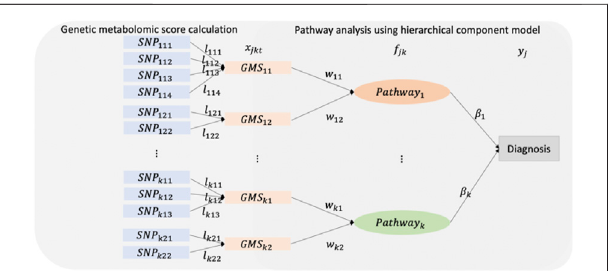
FIGURE 1 | A schematic diagram of the